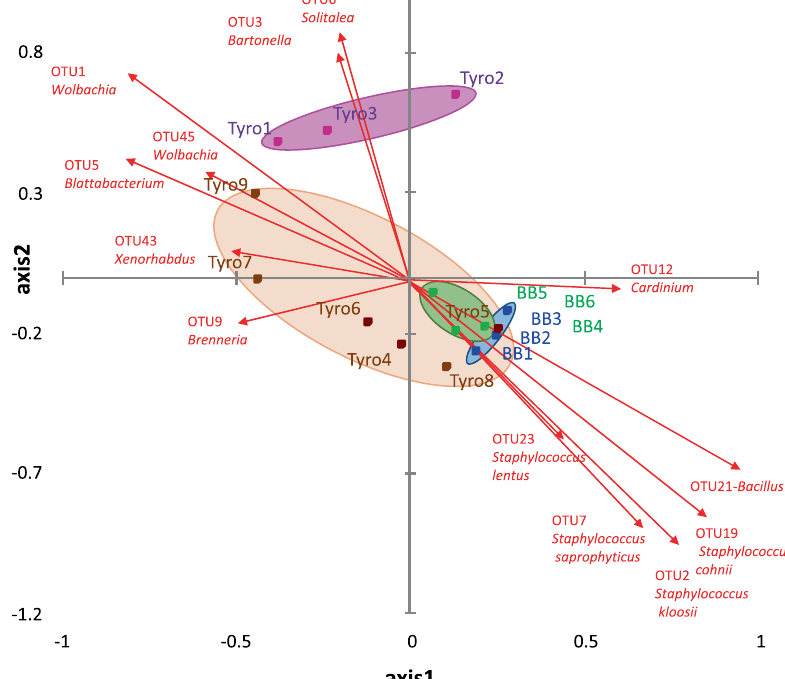
Figure 3. Principal coordinate analyses (PCoA) of microbiota in the samples of predatory ( N. cucumeris ) and prey ( T. putrescentiae ) mites. The microbiome was analyzed using Bray-Curtis dissimilarity matrix; OTUs responsible for significant differences between microbiotas are represented by arrows (calculated via Pearson correlation coefficient). BB1-3 = N. cucumeris (laboratory); BB4-6 = N. cucumeris (mass-reared); Tyro1-3 = T. putrescentiae laboratory culture without the presence of predatory mite (pure) and Tyro4-9 = from N. cucumeris mass-rearing The samples are described in Table 1, the OTUs are identified in Table S1.